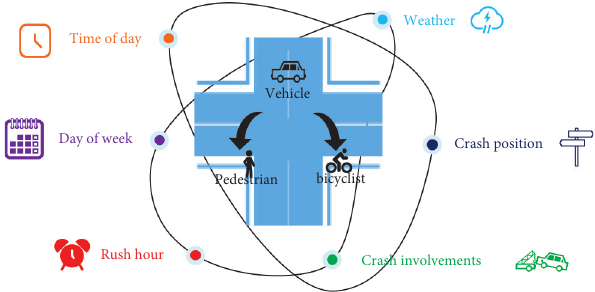
Figure 1: Selected factors related to